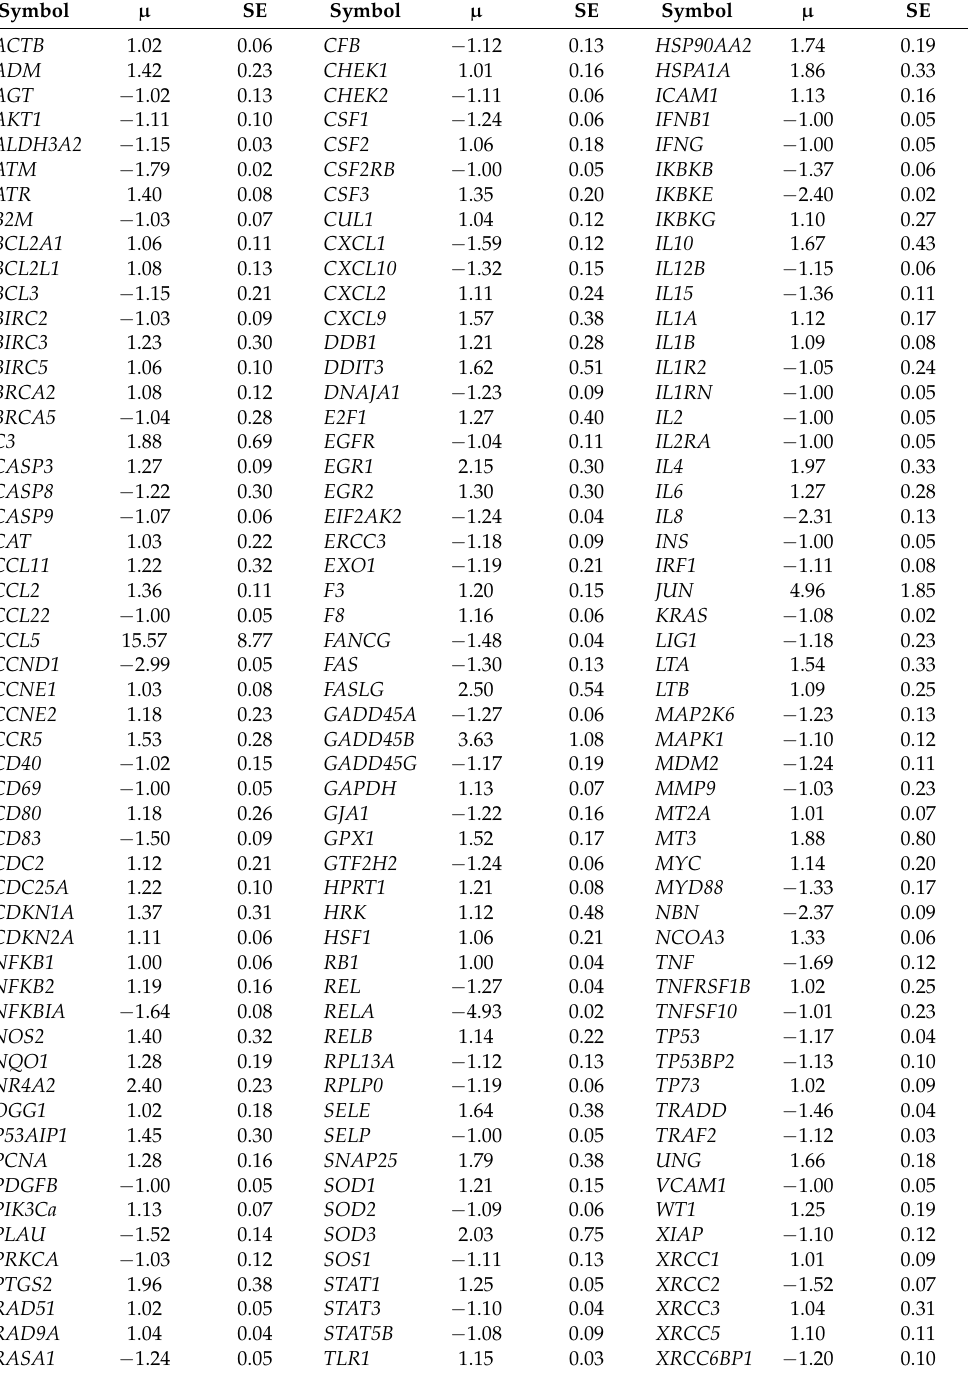
Table A3. Basal gene expression in HEK shRNA RelA cells compared to the original cell line HEK-pNF- κ B-d2EGFP/Neo L2 using the RT2 Profiler PCR